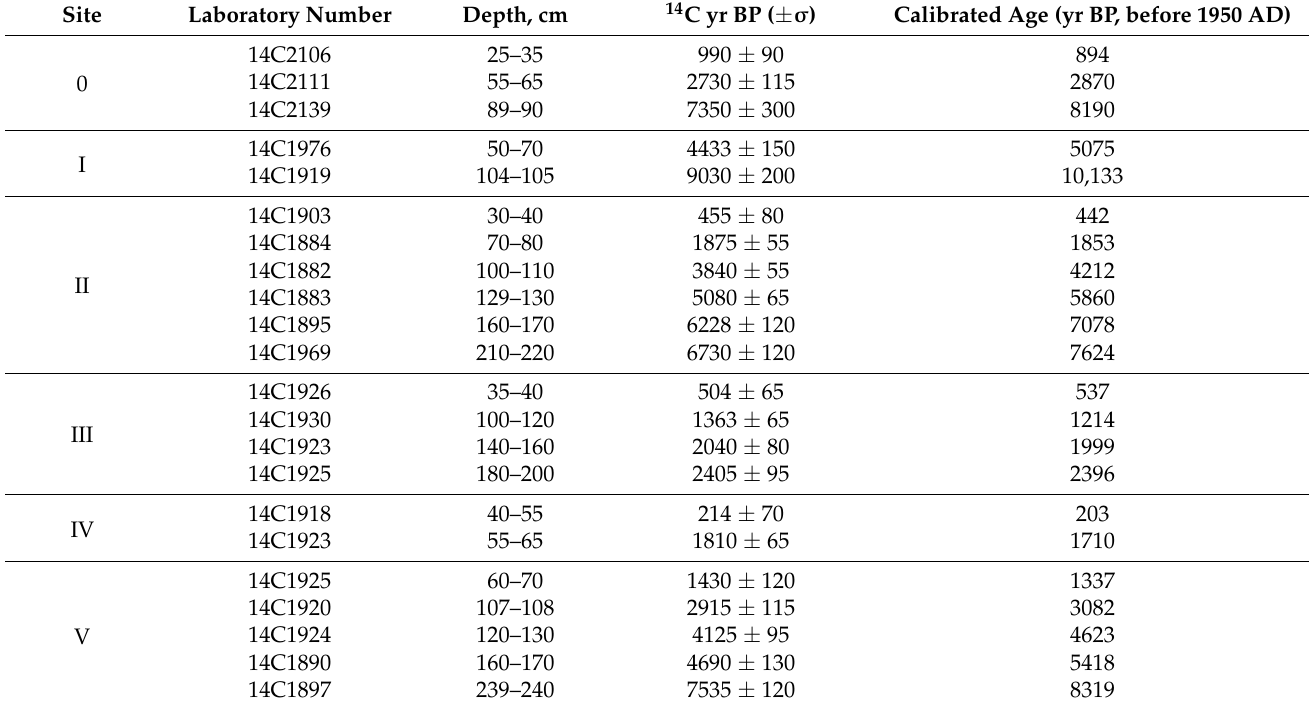
Table 1. Radiocarbon dating of peat.